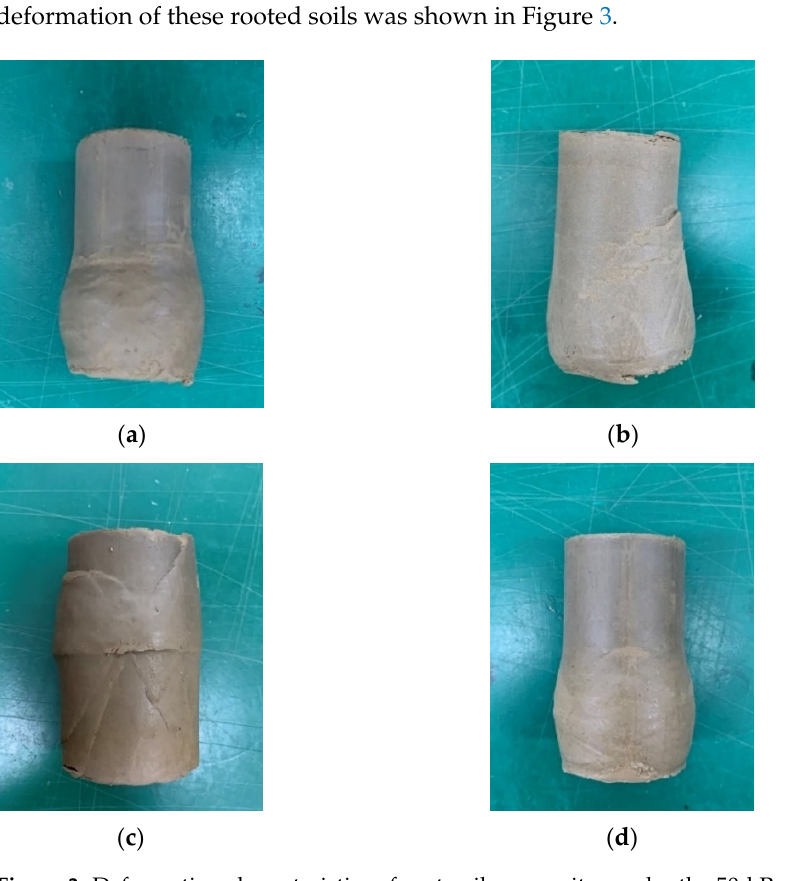
Figure 3. Deformation characteristics of root ‐ soil composites under the 50 ‐ kPa confining pressure and 0.5 ‐ mm root diameter: ( a ) α = 0°, ( b ) α = 30°, ( c ) α = 60°, and ( d ) α = 90°.